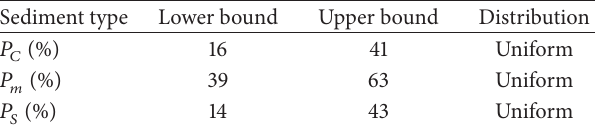
Table 5: Clay, silt, and sand percentages range.